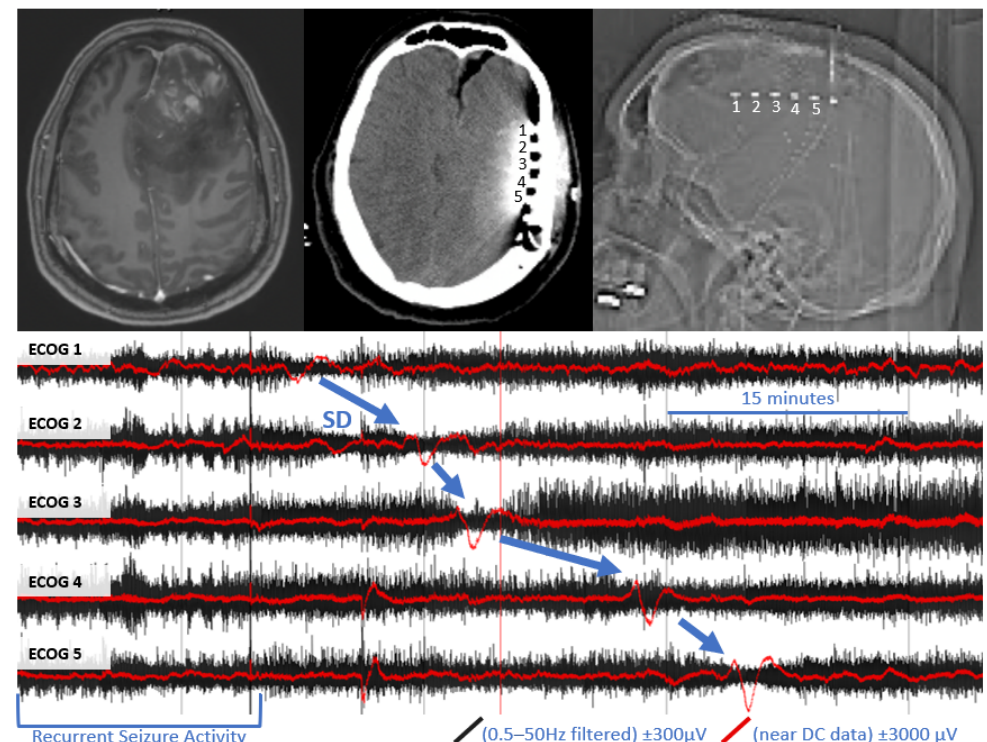
Figure 1. Example of spreading depolarization in a patient with high grade glioma. Upper left panel: pre-operative MRI with and without contrast, demonstrating contrast enhancing left frontal mass with surrounding vasogenic edema. Upper middle panel: post-operative CT, demonstrating the location of the subdural electrode (labeled 1–5) posterior to the tumor resection bed. Upper right panel: scout film from CT also demonstrating the location of the electrode. Bottom panel: referential traces from contacts 1–5 (1 is closest to tumor bed). The black traces represent time compressed, high frequency ECoG data, filtered a 0.5–50 Hz. Overlying red traces represent the same data near DC traces (>0.005 Hz for baseline leveling). A propagating wave of DC shift/slow potential change (in red) that is accompanied by transient suppression of high frequency signaling (in black) is demonstrated (blue